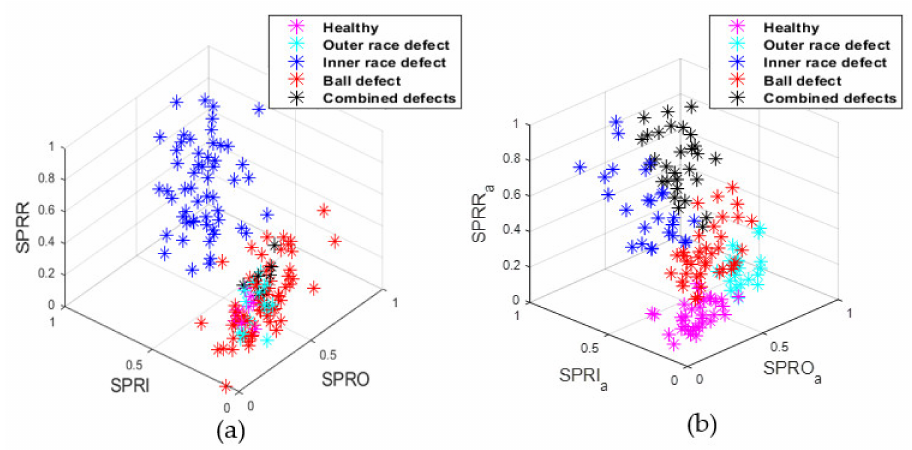
Figure 11. Space representation of the tested 50% of raw data as predicted by the (MSVM) classifier: ( a ) using the non-updated features; ( b ) using the updated ones. Confusion matrices, Tables 2 and 3, are adopted to evaluate the performance of the MSVM classifier in the case of conventional and updated features extracted from raw and pre-processed signals respectively. The present study is performed in the balanced class case which makes the accuracy of classification sufficient criterion to evaluate the classifier performance. The classification accuracy is achieved as shown in Equation (14), by counting the data labeled as true positives TP, true negatives TN, false positives FP, and false negatives FN.